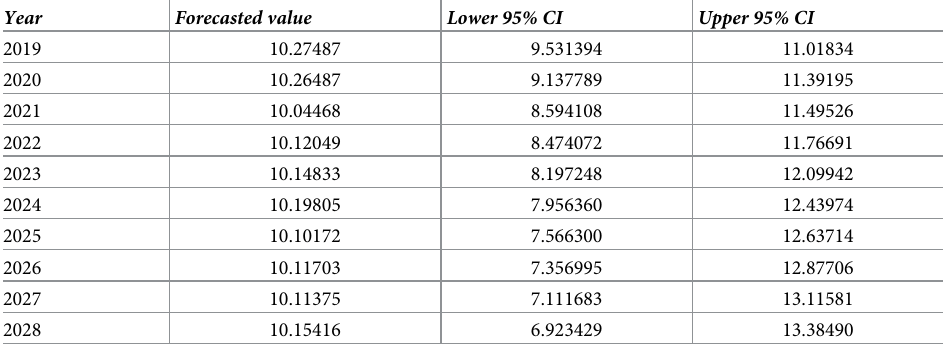
Table 5. Forecasted value of suicide rate for next 10 years based on ARIMA(4,1,0) model with 95% confidence interval.